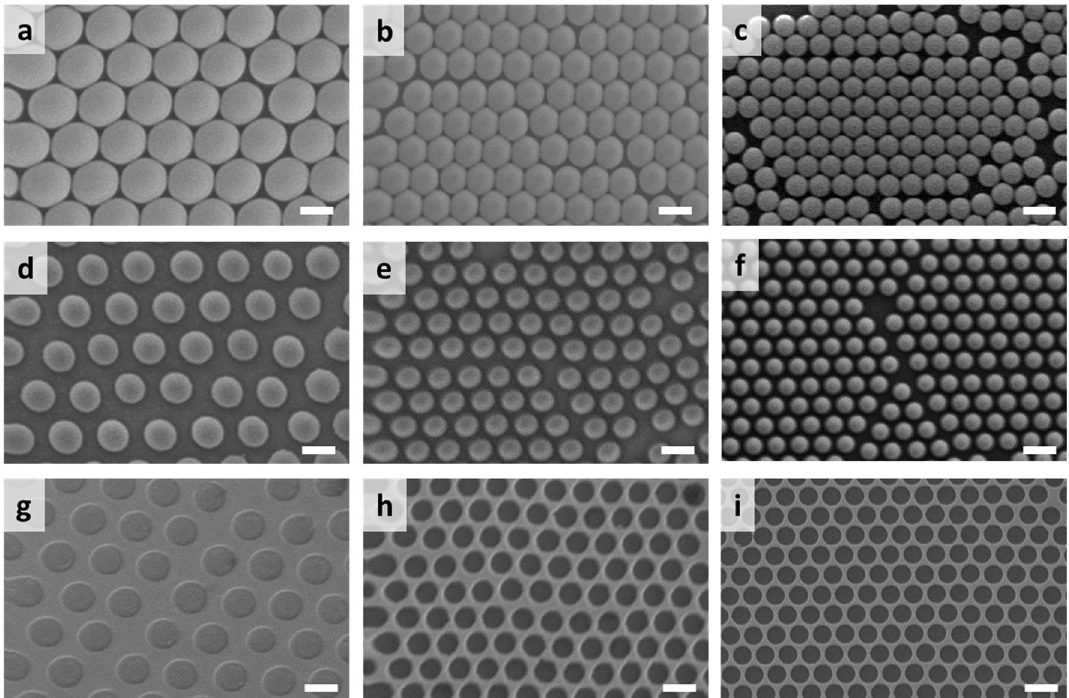
Figure 2. SEM images of ( a – f ) nanoparticles and ( g – i ) molds: ( a – c ) monolayers of ( a ) 780, ( b ) 510, ( c ) 356 nm nanoparticles. ( d – f ) monolayers of ( d ) 780, ( e ) 510, ( f ) 356 nm nanoparticles after RIE. ( g – i ) molds with